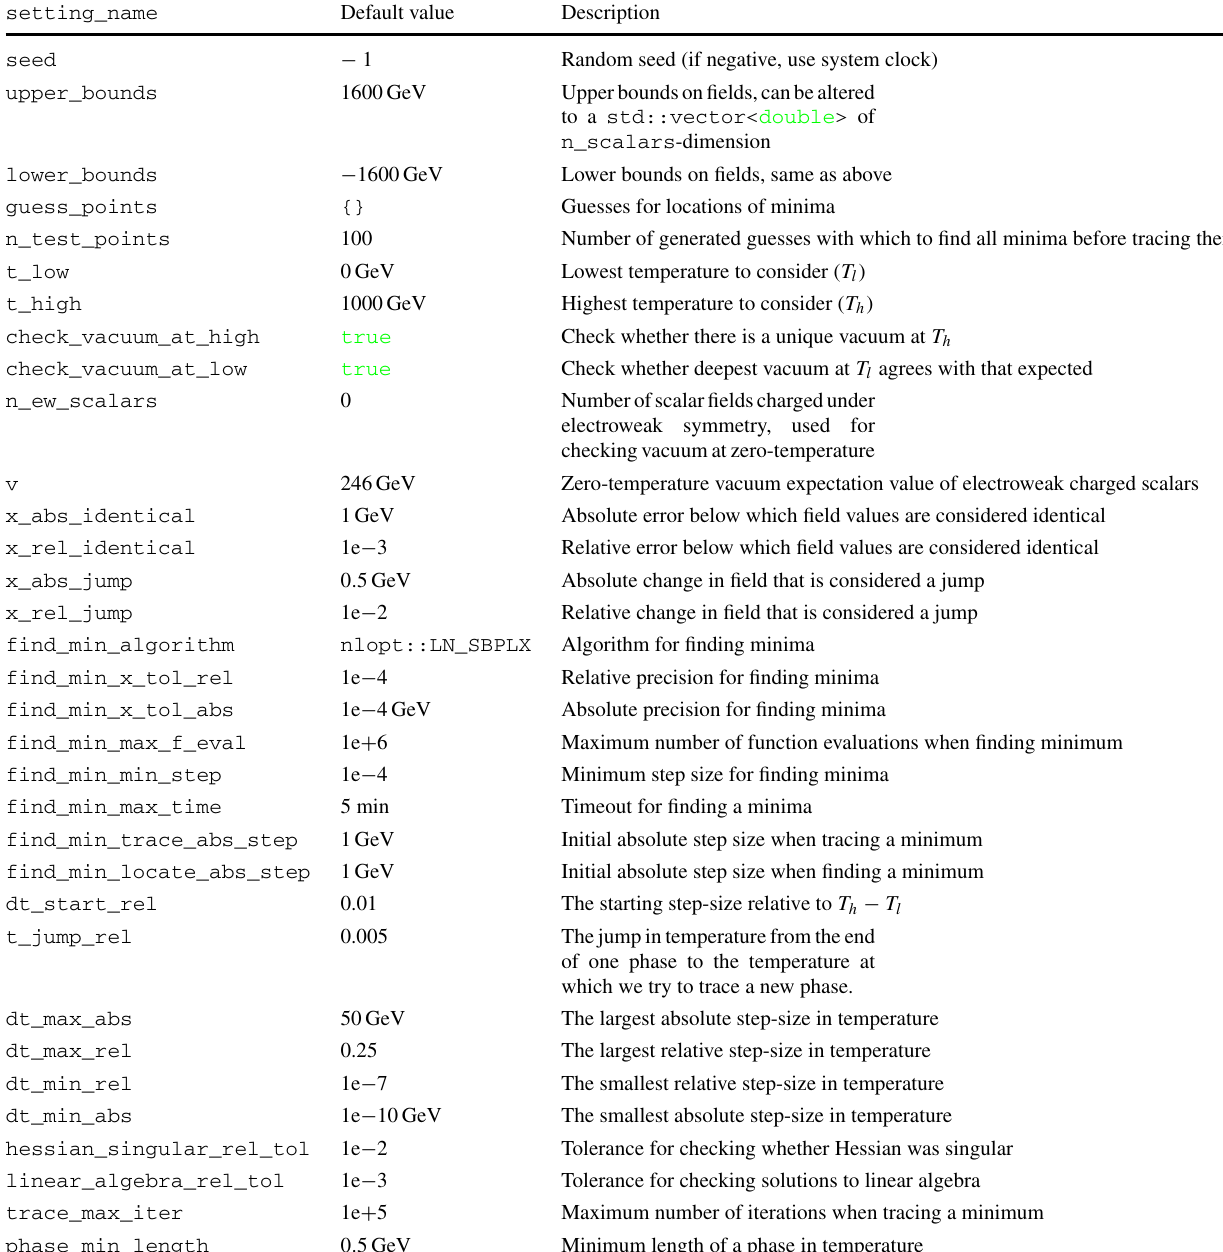
Table 1 Adjustable settings that control the behavior of a PhaseFinder object. Each setting has get_{setting_name} and set_{ setting_name} getter and setter methods